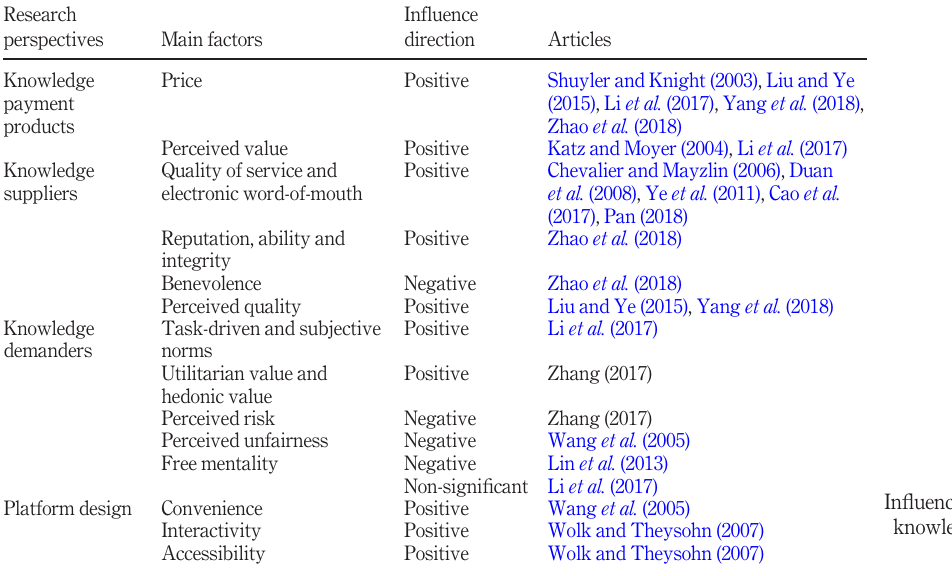
Table V. In fl uencing factors